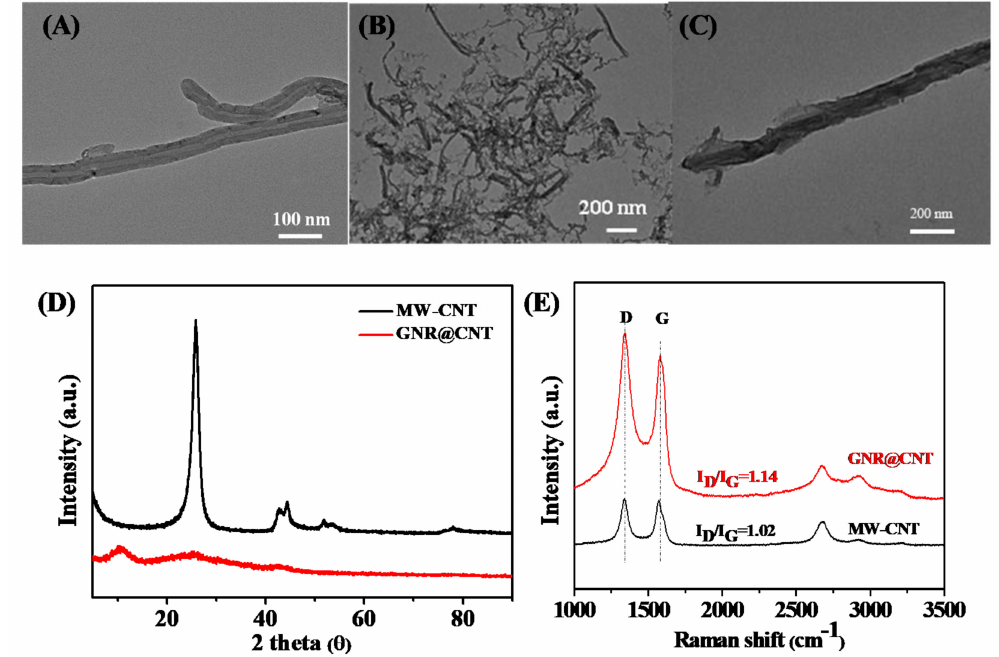
Figure 2. TEM images of: ( A ) pure multiwall carbon nanotube (MW-CNT) and ( B , C ) GNR@CNT; ( D ) XRD patterns of pure CNT and GNR@CNT; ( E ) Raman spectra of pristine CNT and GNR@CNT.